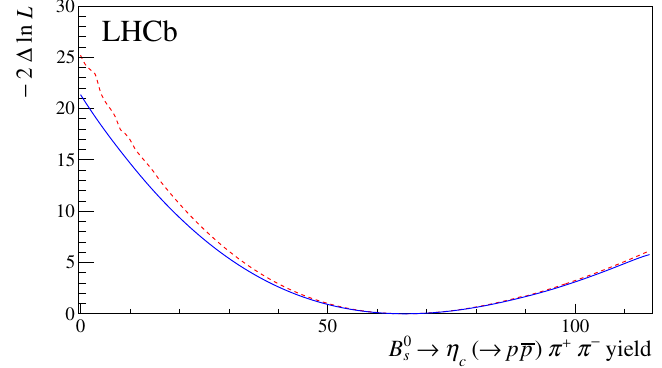
Figure 3 . One-dimensional scan of (cid:0) 2(cid:1) ln L as a function of the (cid:17) c yield in the (cid:12)t to the p (cid:22) p invariant-mass distribution for B 0 ! p (cid:22) p(cid:25) + (cid:25) (cid:0) candidates. The dotted red and solid blue curves s correspond to the result of the scan including statistical only and summed (statistical and system- atic) uncertainties,